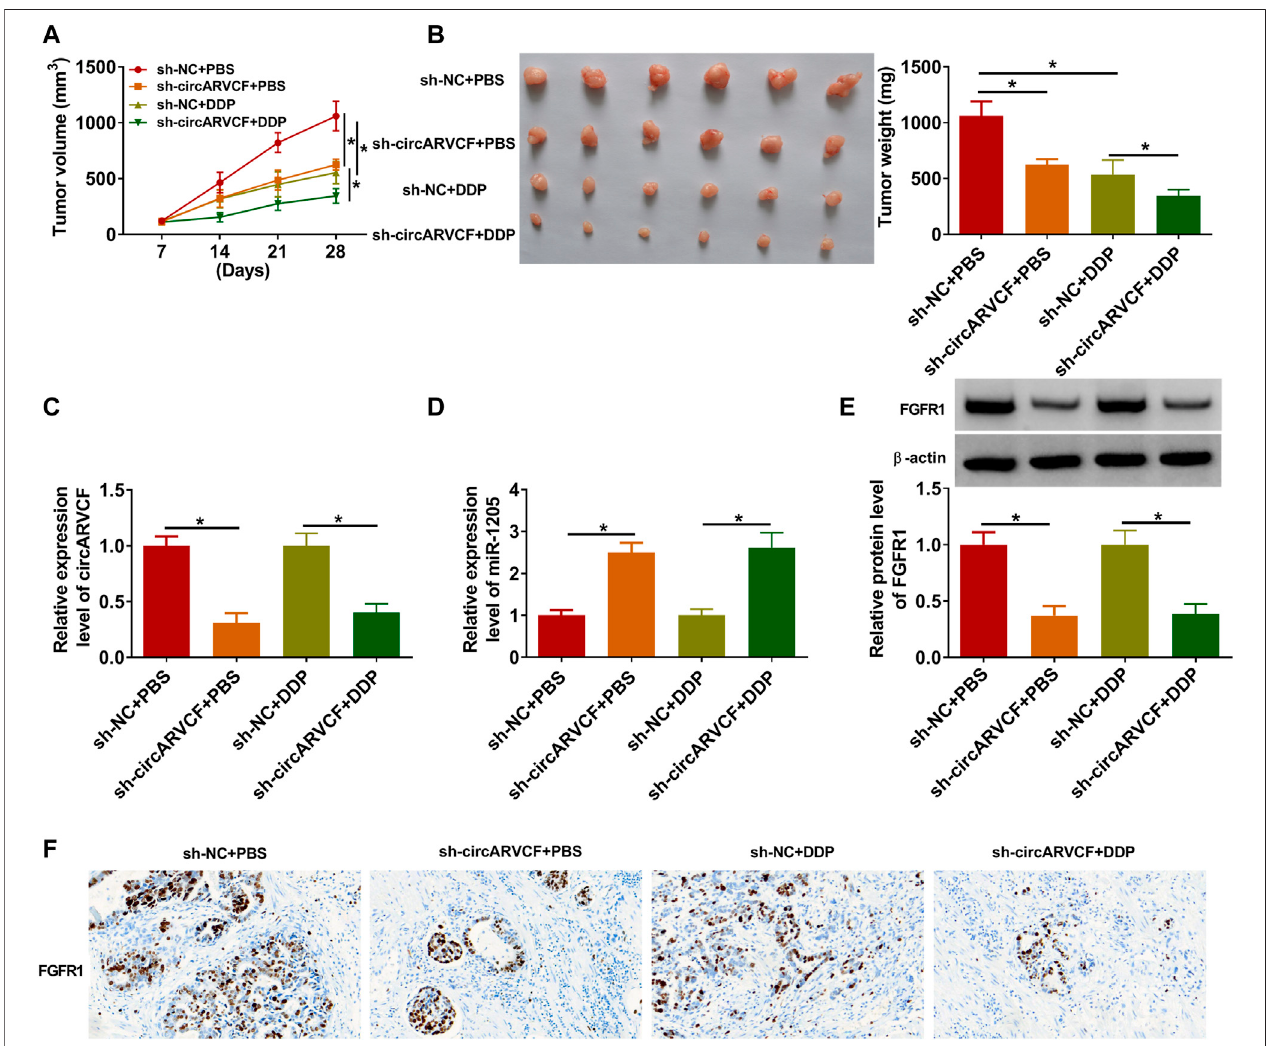
FIGURE 7 | CircARVCF enhanced DDP resistance in GC in vivo . (A,B) Tumor volume and tumor weight were examined. (C,D) The levels of circARVCF and miR- 1205 in the tumors were examined by qRT-PCR. (E,F) The level of FGFR1 in the tumors was examined by western blot assay and IHC assay. * p < 0.05.